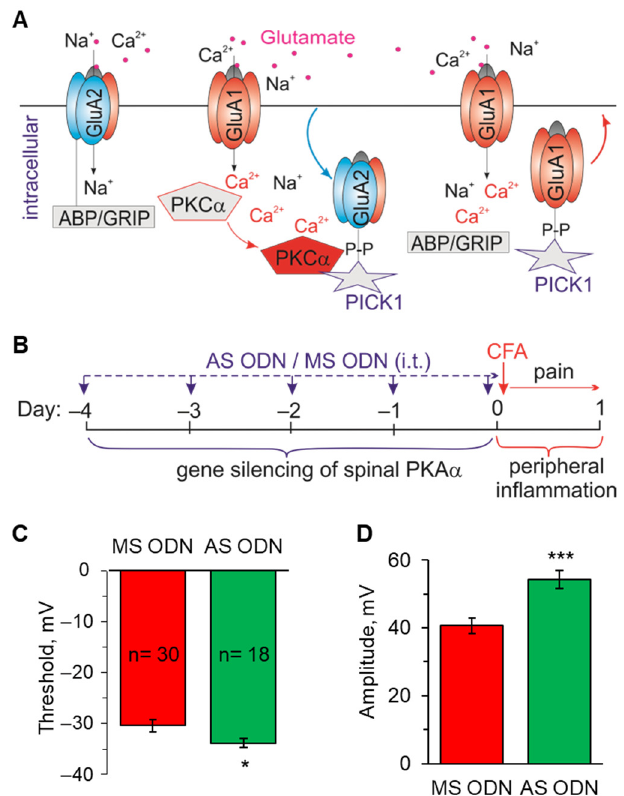
Figure 6. Knockdown of the molecular mechanism mediating the upregulation of Ca 2+ ‐ permeable AMPARs restores the AP parameters in lamina I − II DH neurons. ( A ) A schematic illustration of the cascade of signalling events mediating the internalisation of GluA2 ‐ containing, Ca 2+ ‐ impermeable AMPARs from synapses and the upregulation of GluA1 ‐ containing, Ca 2+ ‐ permeable AMPARs in lamina I − II neurons in persistent inflammatory pain. ABP/GRIP protein binds to and anchors GluA2 at the membrane; an increase in nociceptive drive from the periphery activates postsynaptic gluta ‐ mate receptors, increases Ca 2+ influx into the superficial DH neurons activating PKC α ; the latter phosphorylates GluA2 and disrupts the receptor’s binding to ABP/GRIP, which leads to the inter ‐ nalisation of GluA2 ‐ containing AMPARs and insertion of GluA1 ‐ containing, Ca 2+ ‐ permeable AM ‐ PARs in the plasma membrane. ( B ) An experimental scheme of the knocking down of spinal PKC α with AS ODN administered intrathecally (i.t., 10 μ L/rat) before the induction of peripheral inflam ‐ mation daily for 4 days. ( C,D ) Statistical summary of the AP threshold ( C ) and the amplitude ( D ) in lamina I − II DH neurons in the CFA ‐ inflamed animals after AS − or MS − ODN treatment. All data are means with SEM; the number of recorded cells is indicated. * p < 0.05, *** p < 0.001 (unpaired two ‐ tailed t ‐ test). Thus, Ca 2+ ‐ permeable AMPARs markedly contribute to the inflammatory ‐ driven neuronal hyperexcitability in the superficial DH by shifting the threshold of firing in lam ‐ ina I ‐ II neurons to more depolarised potentials in conditions of persistent peripheral in ‐ flammation. 2.4. Knockdown of Upregulated Ca 2+ ‐ Permeable AMPARs in the Spinal Cord Restores the AP Parameters in Lamina I ‐ II Neuronal Classes in Persistent Peripheral Inflammation We next examined whether Ca 2+ ‐ permeable AMPARs play a role in the cell ‐ specific changes of AP parameters in lamina I ‐ II DH neurons. Here, we focused on the tonic firing and initial bursting neuronal classes, in which changes were found as described above. In tonic firing neurons, AS ODN treatment recovered the AP amplitude at 1 d post ‐ CFA compared to that in the CFA ‐ inflamed animals treated with MS ODN (55.7 ± 2.9 mV, n = 13 after AS ODN versus 49.2 ± 2.0 mV, n = 9 after MS ODN, p < 0.05; Figure 7B). The magnitude of APs in these neurons recovered back to levels observed in the control, non ‐